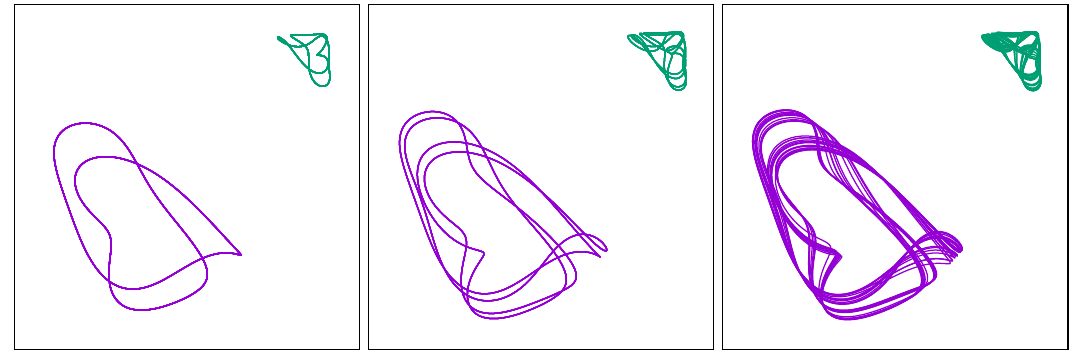
Figure 8. Period doubled versions of two coexisting periodic orbits ( left and middle ) and the coexistence of two chaotic attractors after a full cascade ( right ). All of the panels represent the square [ − 0.1,0.9 ] × [ − 0.1,0.9 ] in the ( x 0 , x 2 ) -plane. The used parameter values are: F = 0.6495 ( left ), F = 0.6539 ( middle ), and F = 0.654502 ( right ).